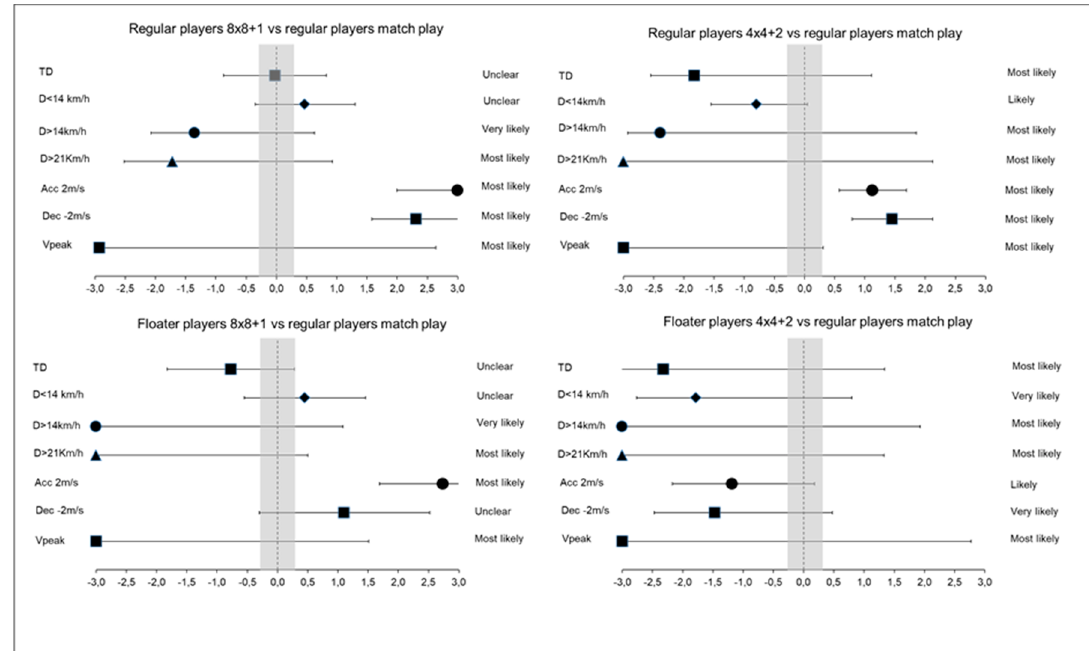
Figure 2. Forest plot showing the effect sizes (with associated confidence intervals) for the physical demand comparisons between regular players and floater players in SSGs and match-play. The shaded area, spanning 0.2 to − 0.2, represents nonmeaningful effect size. TD: total distance D: Distance; Acc: Acceleration; Dec: Deceleration; Vpeak: Peak velocity.